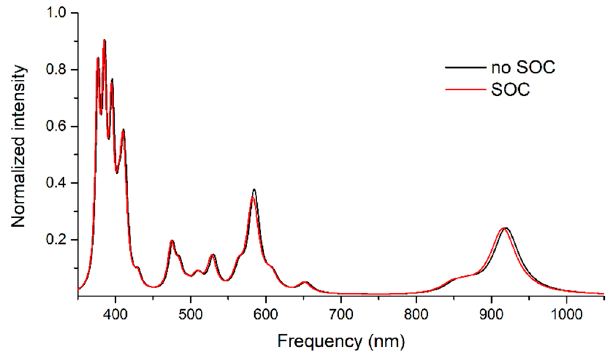
Figure 5. The theoretical UV absorption spectra calculated with and without spin-orbit effects for the singlet spin configuration of the C6 equilibrium geometry at TD-DFT/M06/def2-TZVP level of theory.